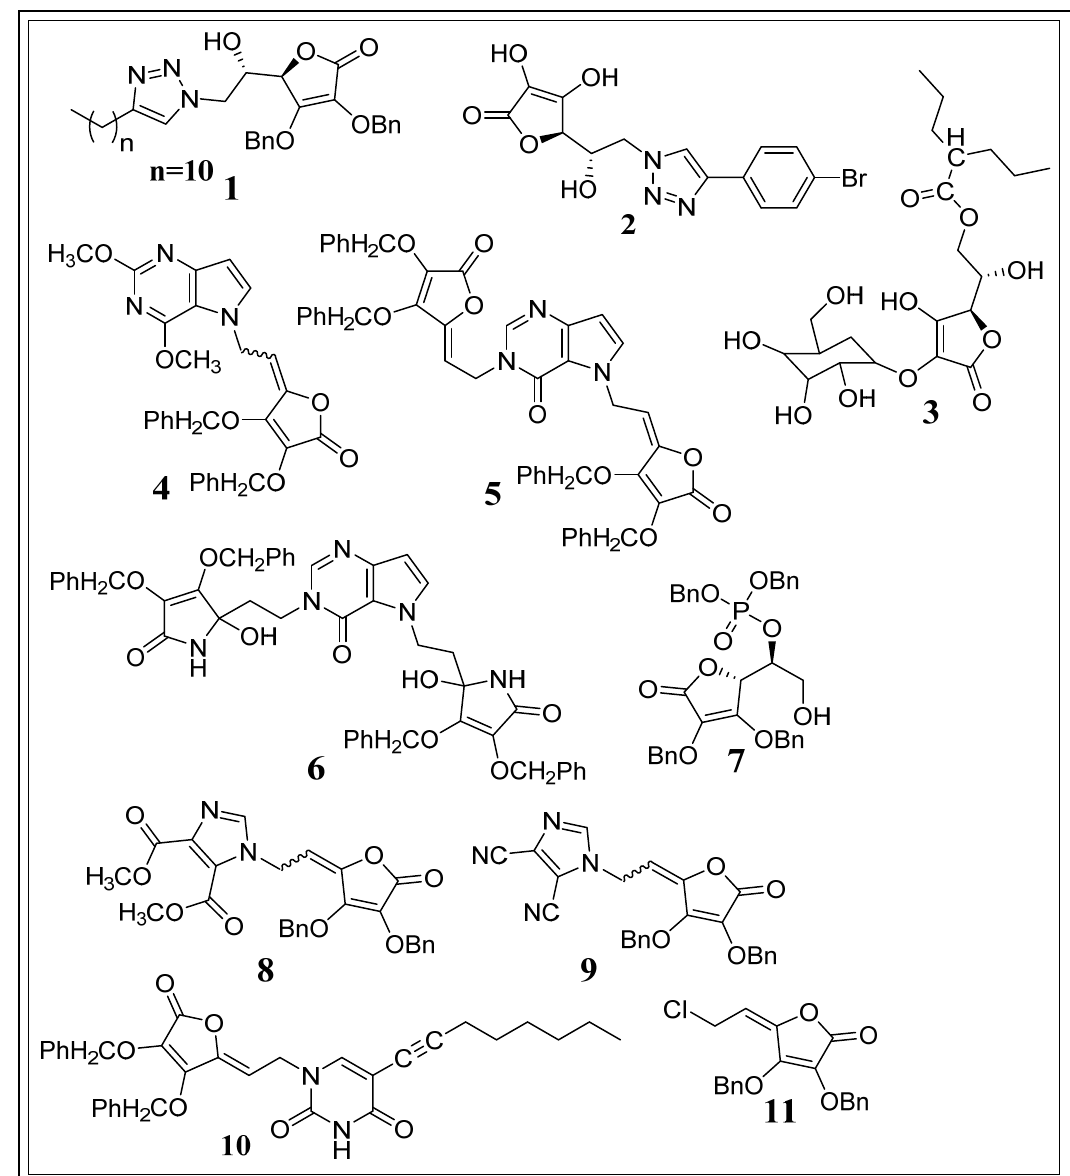
spite comprising only 10 per cent of the molar amount of the control substance dose. This study suggested that compound 3 after administration converted to its metabolite AA-2G, which later oxidized to DHA and selectively killed the cancer cells through induction and increased endogenous oxidative stress [92].